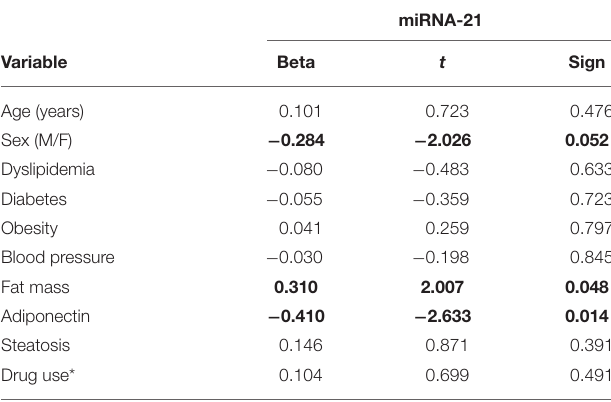
TABLE 4 | Linear regression analysis with miRNA-21 as the dependent variable.